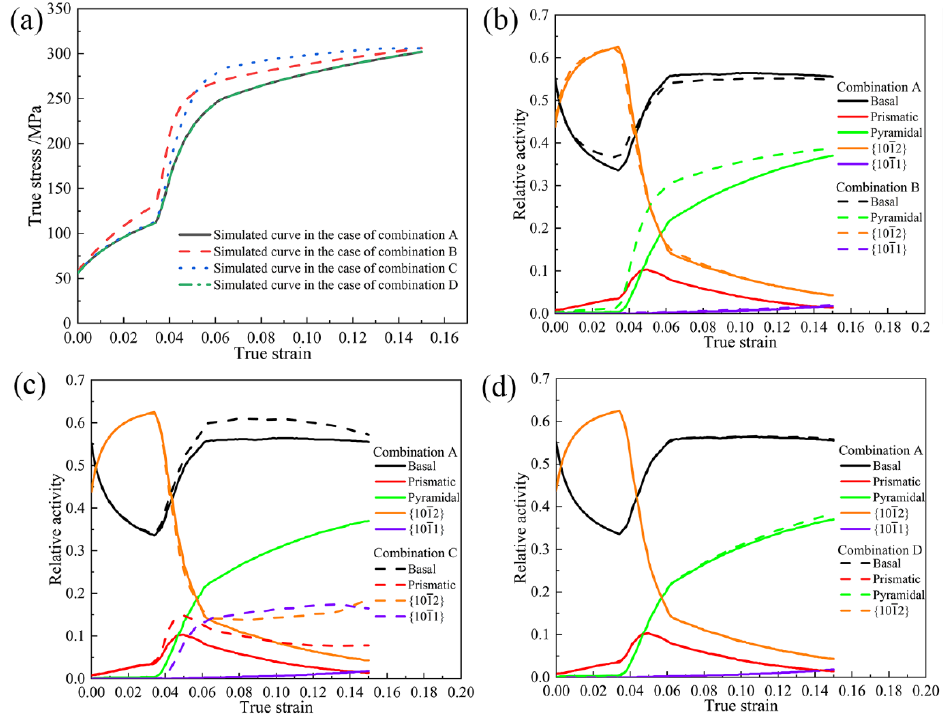
Figure 2. ( a ) The predicted stress–strain curves of AZ31 magnesium alloy under IPC along RD; ( b – d ) the corresponding slip and twinning activities predicted by the VPSC modeling in the cases of combination B, combination C, and combination D, respectively.